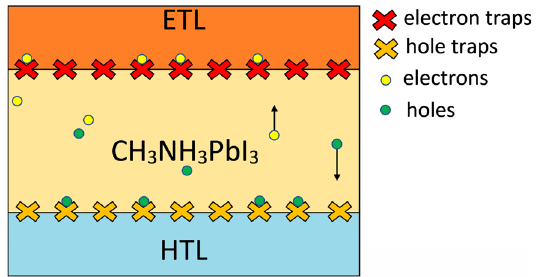
Figure 5. Problems associated with the interface of perovskite absorber layer/ETL and perovskite absorber